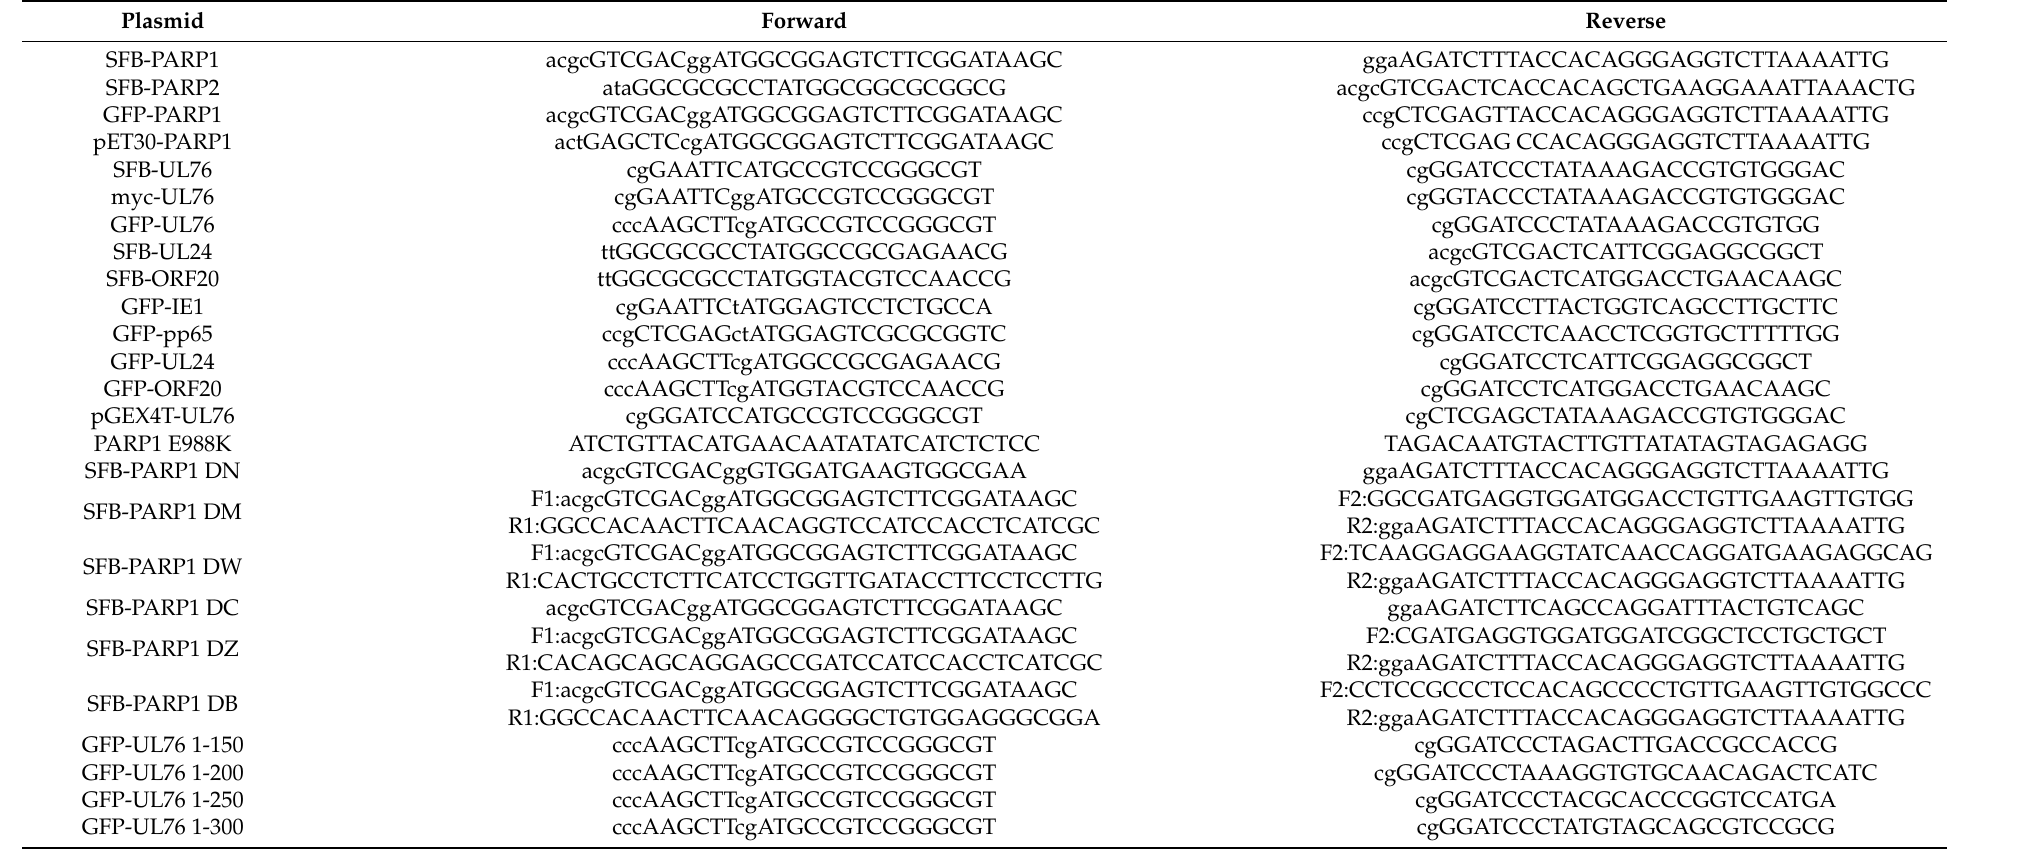
Table 1. Primers used for plasmid